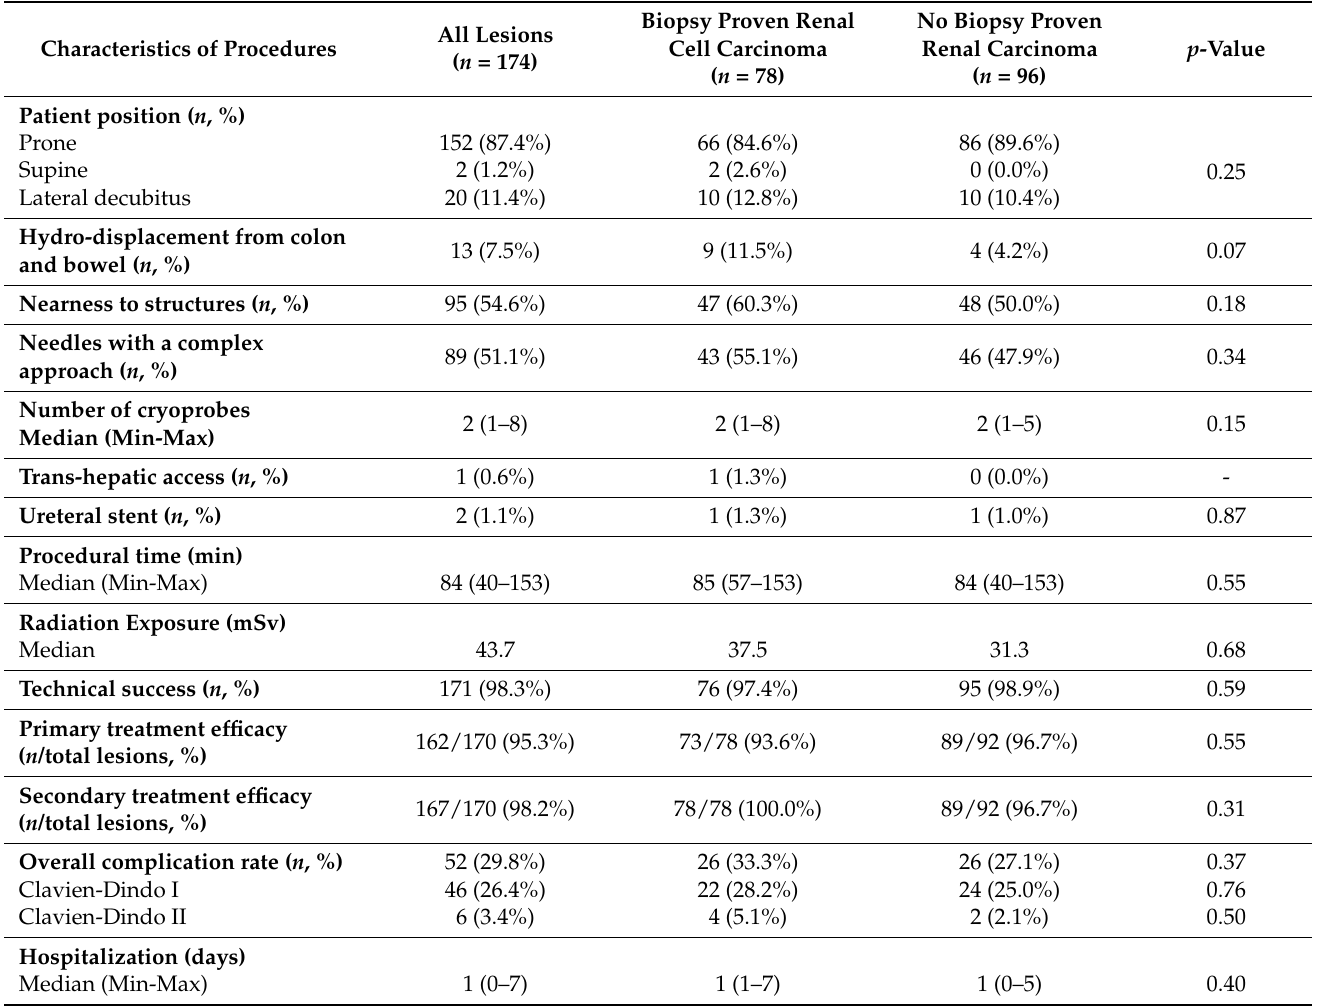
Table 3. Characteristics of cryoablation